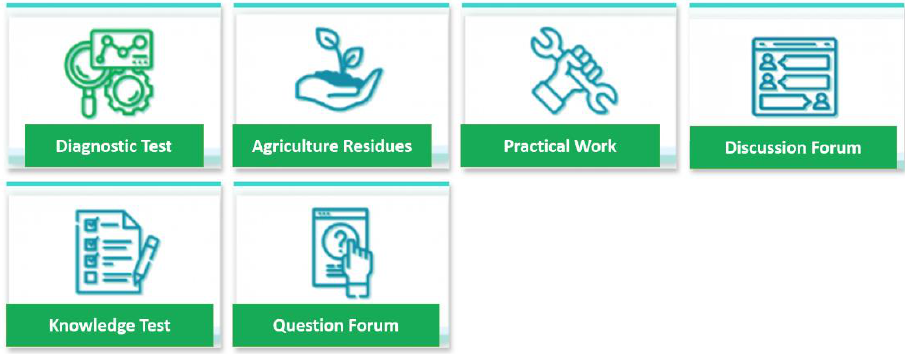
Figure 3. List of different learning activities included in the Agricultural Residues MOOC.